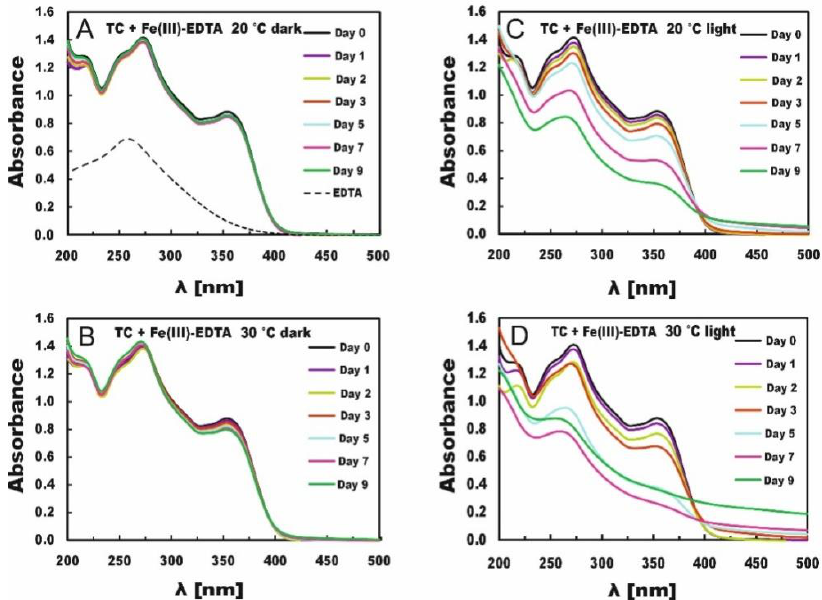
Figure 1. Changes in absorption spectra of TC in the presence of Fe(III)-EDTA. The samples were stored in the dark ( A , B ) or in light ( C , D ) at 20 °C ( A , C ) and 30 °C ( B , D ).